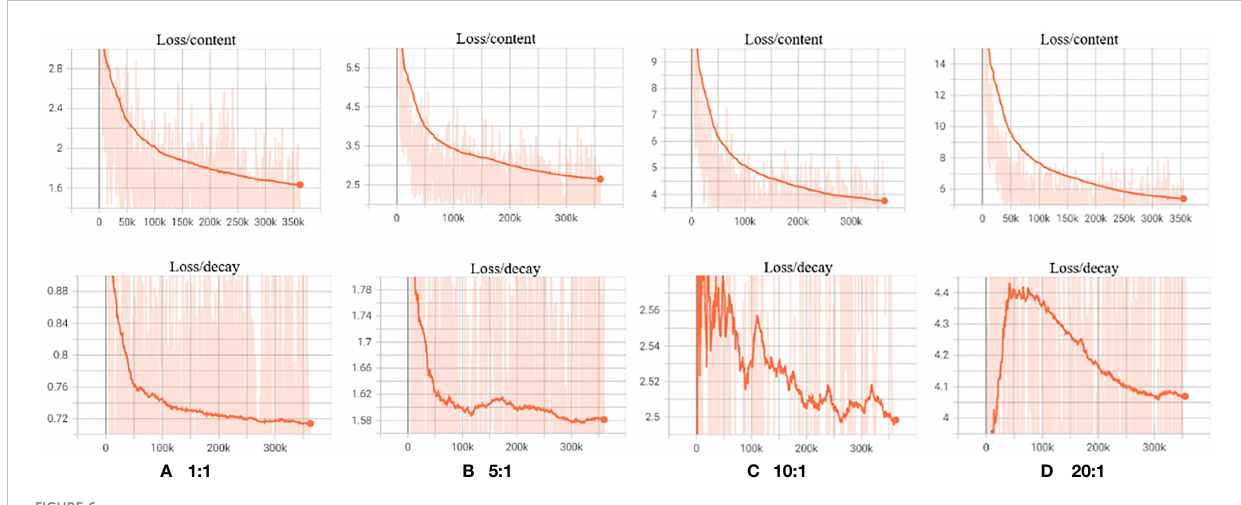
FIGURE 6 The loss function traincurve. (A) L content : L decay 1:1, (B) L content : L decay is 5:1, (C) L content : L decay is 10:1, (D) L content : L decay is